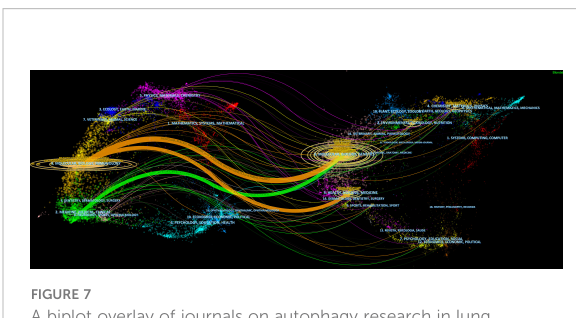
FIGURE 7 A biplot overlay of journals on autophagy research in lung disease (left and right sides refer to the citing journal areas and the cited journal areas,